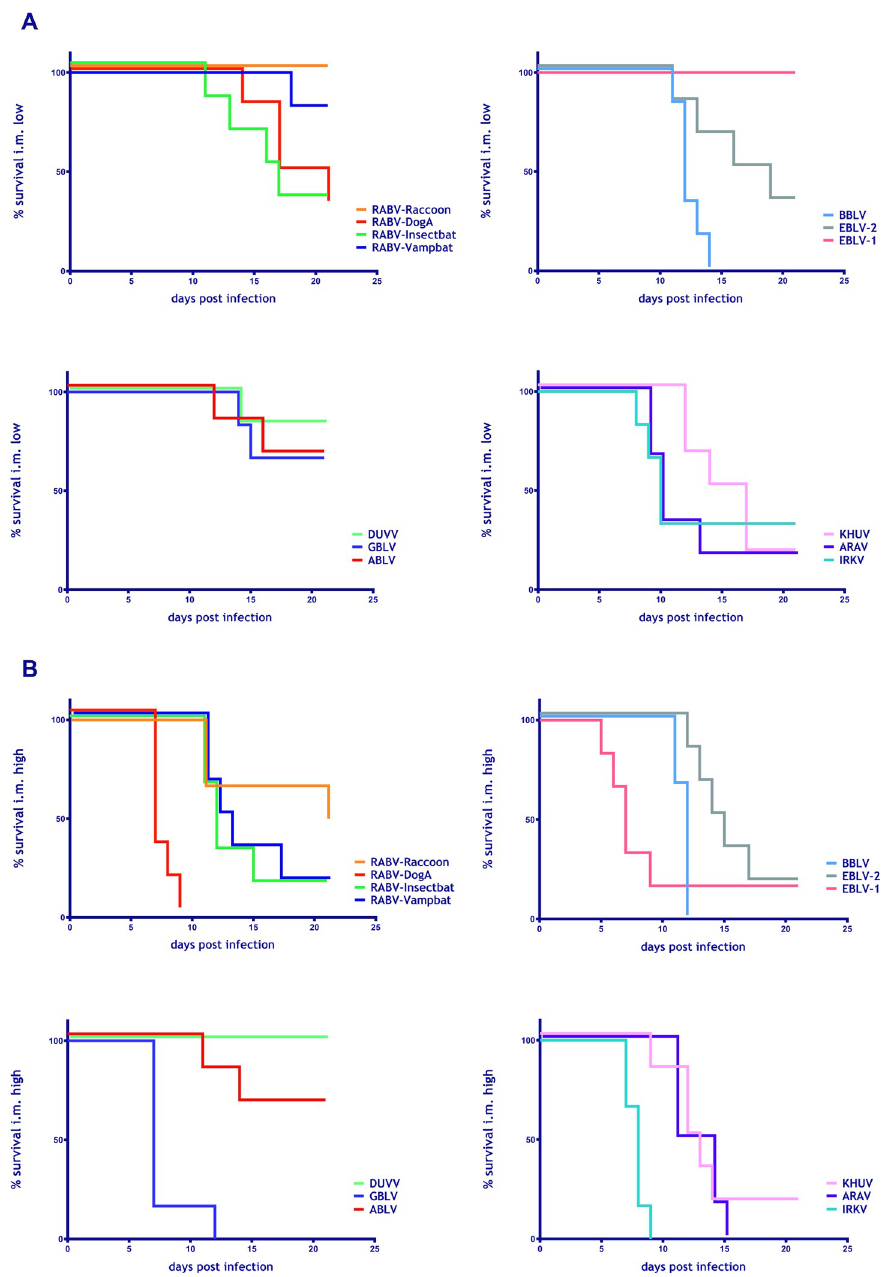
Fig 3. Kaplan-Meyer survival plots of the individual isolates following i.m. infection with low (A) and high doses (B). Six BALB/c mice were inoculated per group. Mock-infected control mice did not develop any clinical signs and, hence, were omitted for better